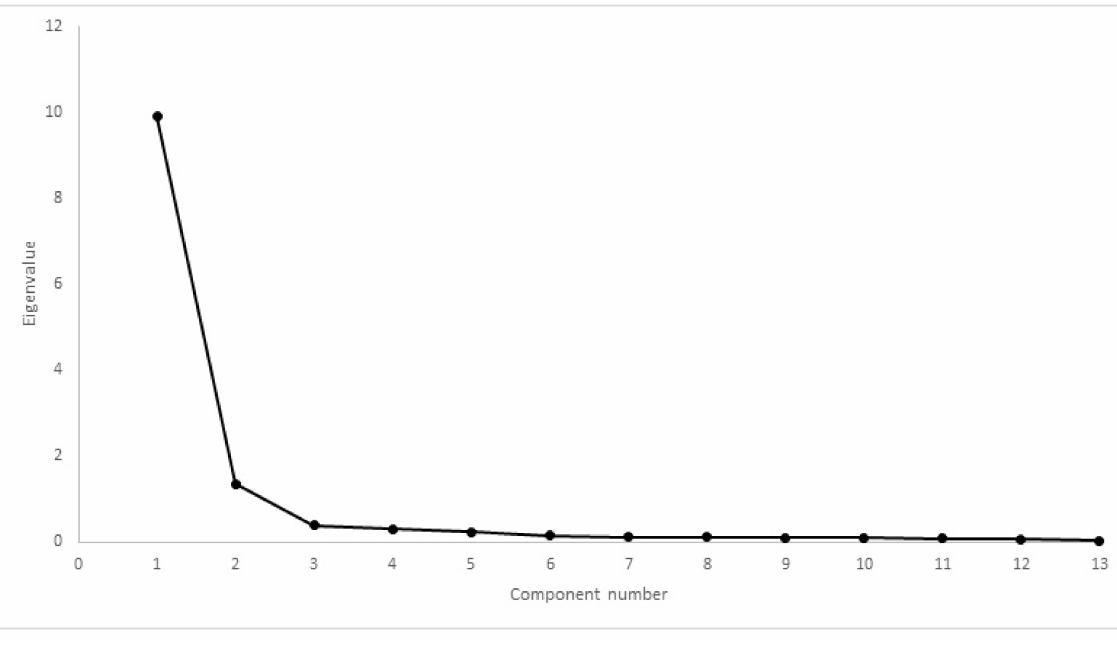
Figure 8. Scree plot of factor analysis of LOAD. Two factors had eigenvalues >1, with a discernible “shoulder” observed.